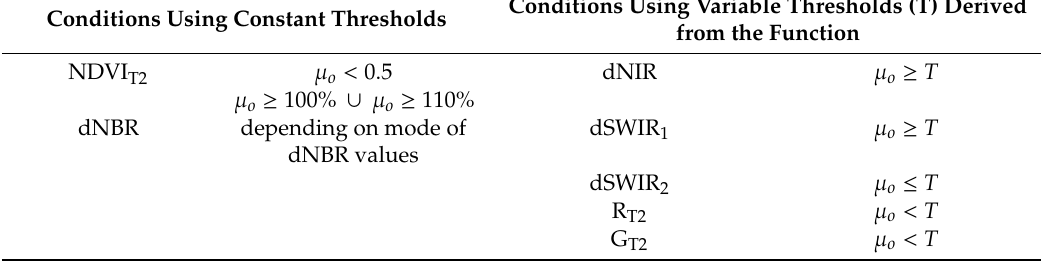
Table 2. Conditions used for core burnt area mapping, µ o is a mean value of object (in the case of dNBR, dNIR, dSWIR 1 , dSWIR 2 µ o is the value of relative mean di ff erence) and in the case of image bands R, G and NDVI index µ o is the absolute mean value). T is the threshold calculated using the function. Conditions Using Variable Thresholds (T) Derived Conditions Using Constant Thresholds from the